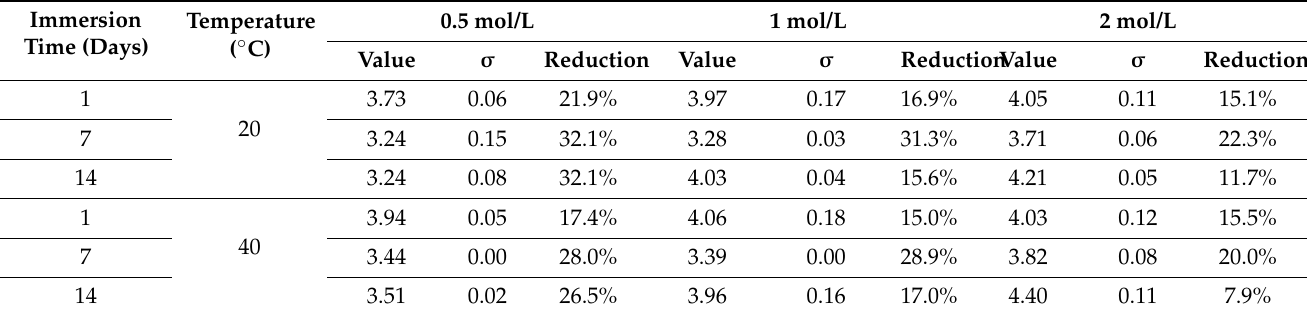
Table 4. Water absorption (%) and its reduction in the treated RFA.